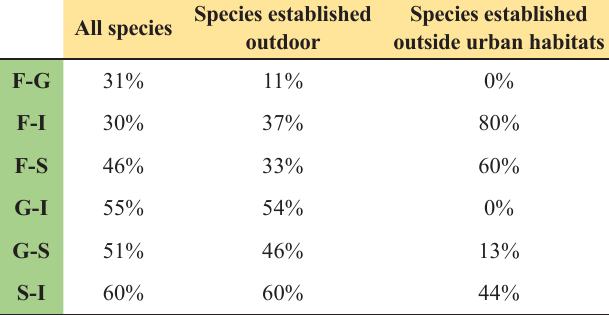
Table 2 . Sørensen-Dice coefficient between exotic ant species present in France – F (Corsica, mainland), Greece – G (Crete, mainland, Peloponnese), Italy – I (mainland, Sicily, Sardinia) and Spain – S (mainland) as defined in this study and listed in Table